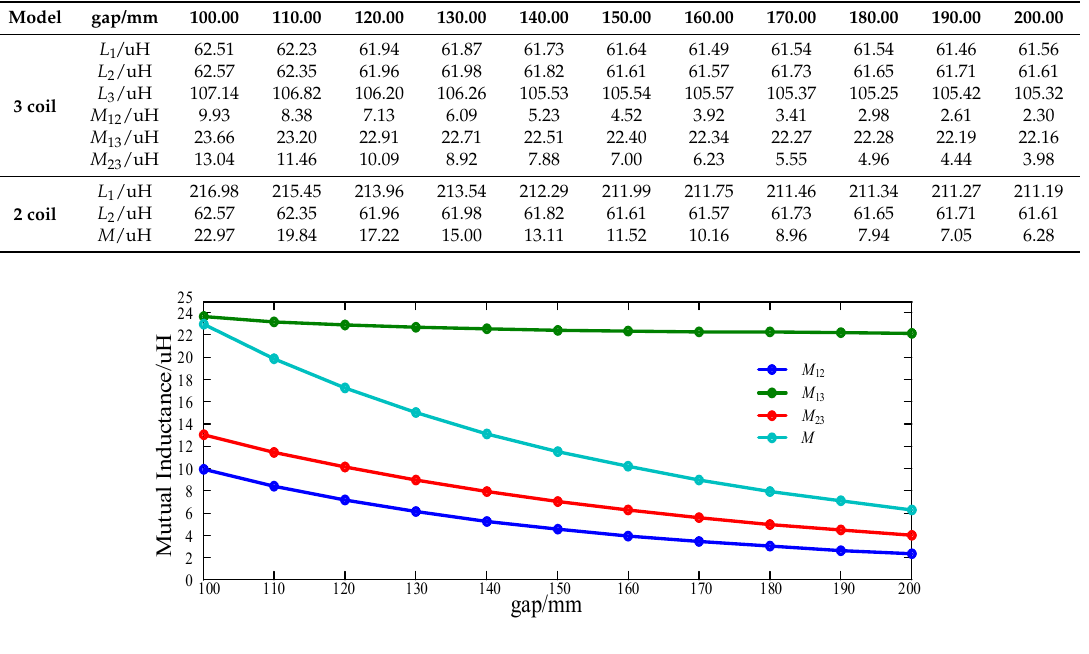
Table 2. Parameters for coupling mechanism for both systems.